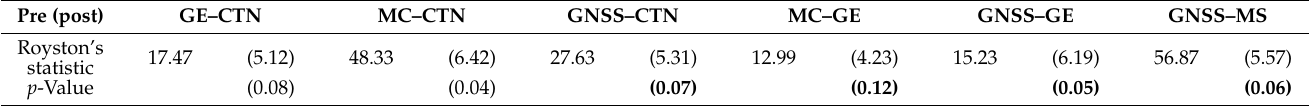
Table 5. Royston’s multivariate normality test of the pairs ∆ E – ∆ N . The equivalent degree of freedom (df) = 2. Values after outliers’ removal are reported between parentheses. p -Values < 0.02 are omitted. The resulting bivariate normal distributions are highlighted in bold.